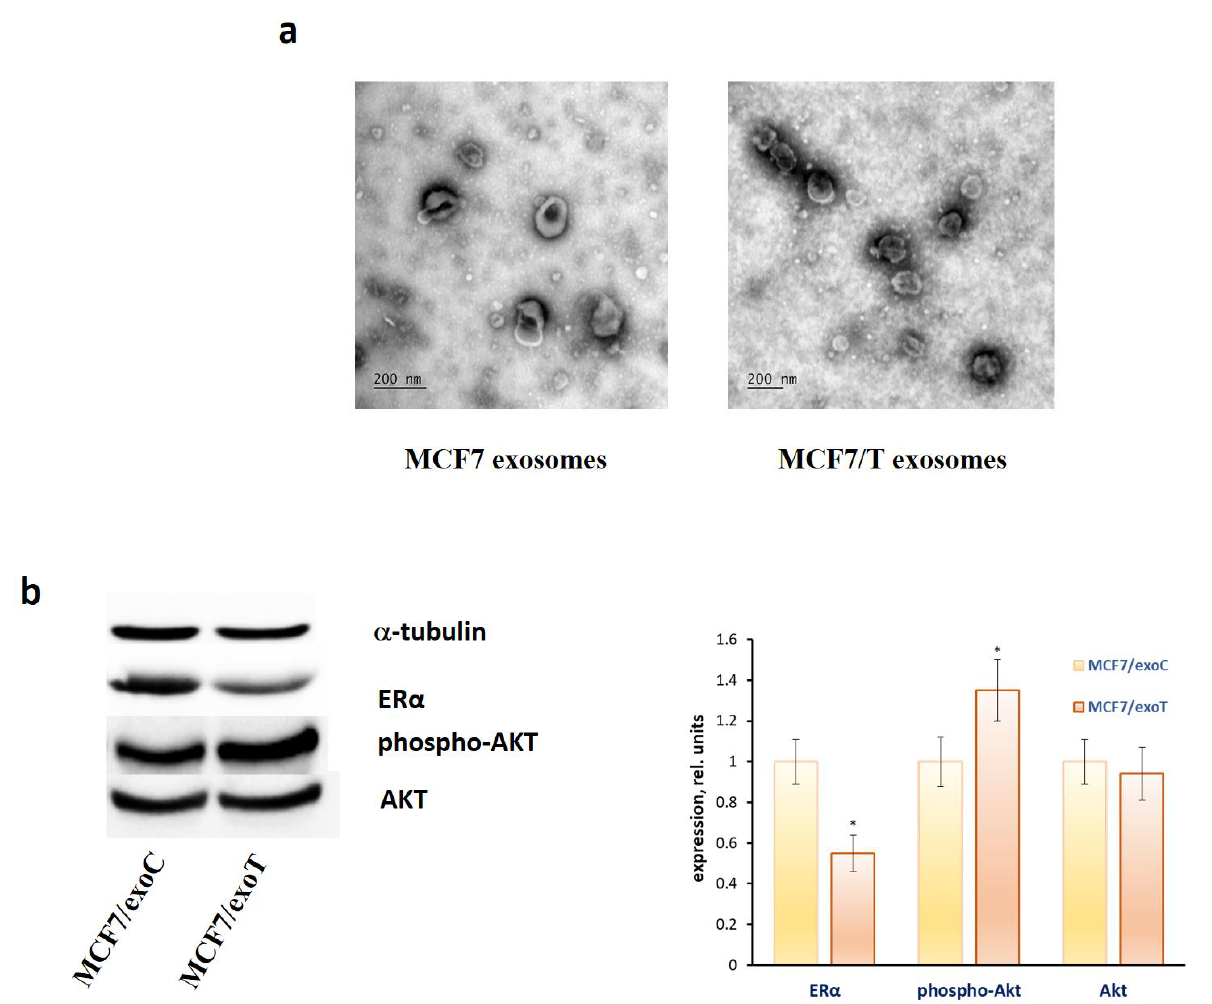
Figure 5. Exosome influence on the ER α and Akt level in MCF7 cells. ( a ) The transmission electron microscopy of the exosomes. Exosomes were collected from the MCF7 and MCF7/T conditioned medium by the differential ultracentrifugation, labelled by the gold nanoparticles and imaged as described in Methods. ( b ) ER α and Akt expression. MCF7 cells were treated with exosomes from MCF7 and MCF7/T for 1 month and Western blot analysis of ER α and Akt was performed in the cell extracts. Protein loading was controlled by membrane hybridization with α -tubulin antibodies. Densitometry for immunoblotting data (right diagram) was carried out using ImageJ software; * p < 0.05 versus scrambled (scr).